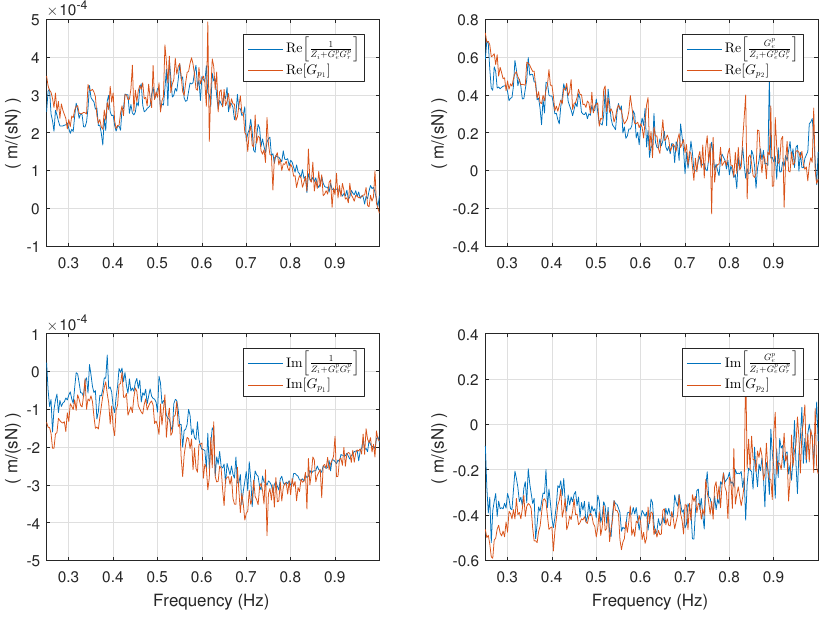
Figure 34. FRFs of the MISO model and of the dual SISO model (shown in Figure